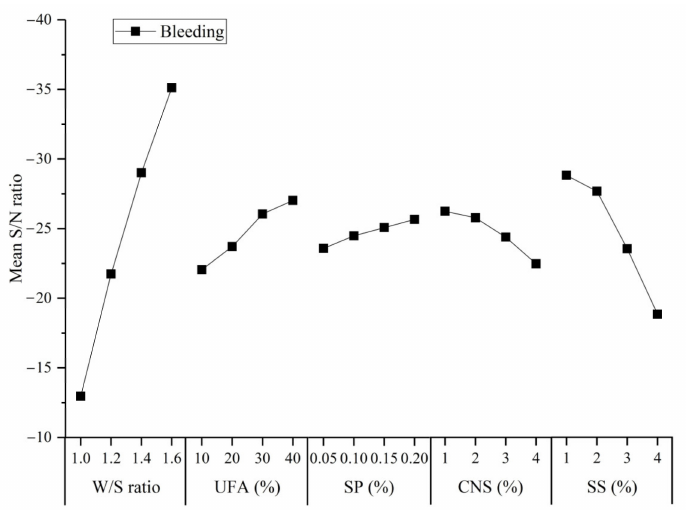
Figure 9. Mean S/N ratio values of the bleeding of the UC-based slurry for different factors.